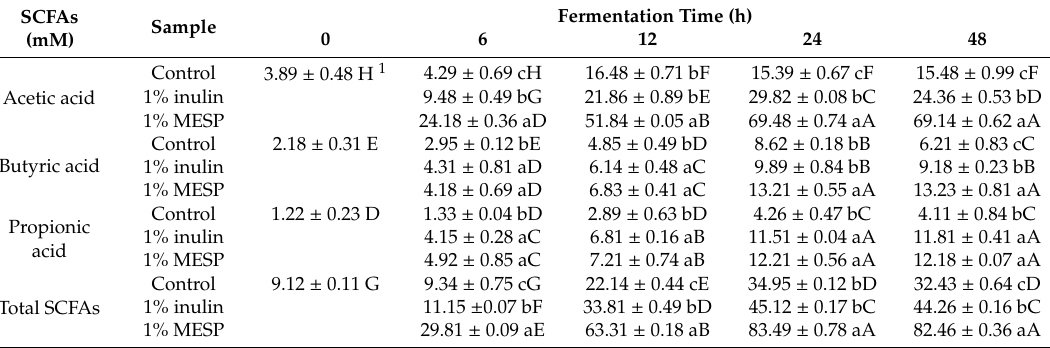
Table3. Concentrationsofshortchainfattyacids(SCFAs)atdi ff erentpointsduringin